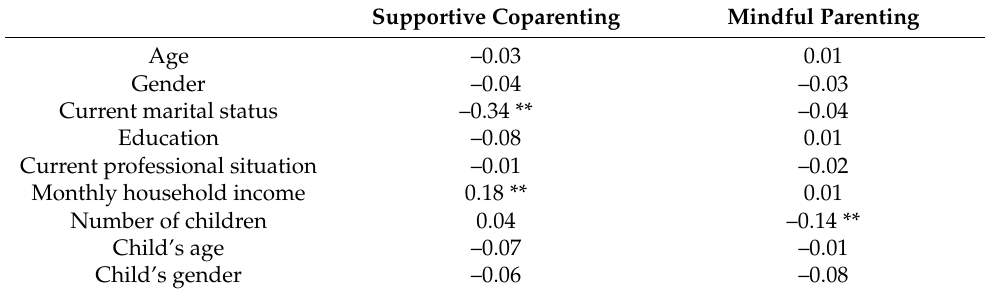
Table 3. Correlations between sociodemographic variables and the mediator and dependent